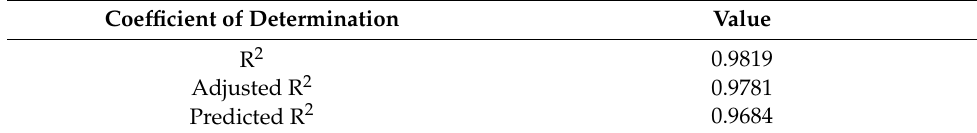
Table 8. Coefficient of determination for CO.